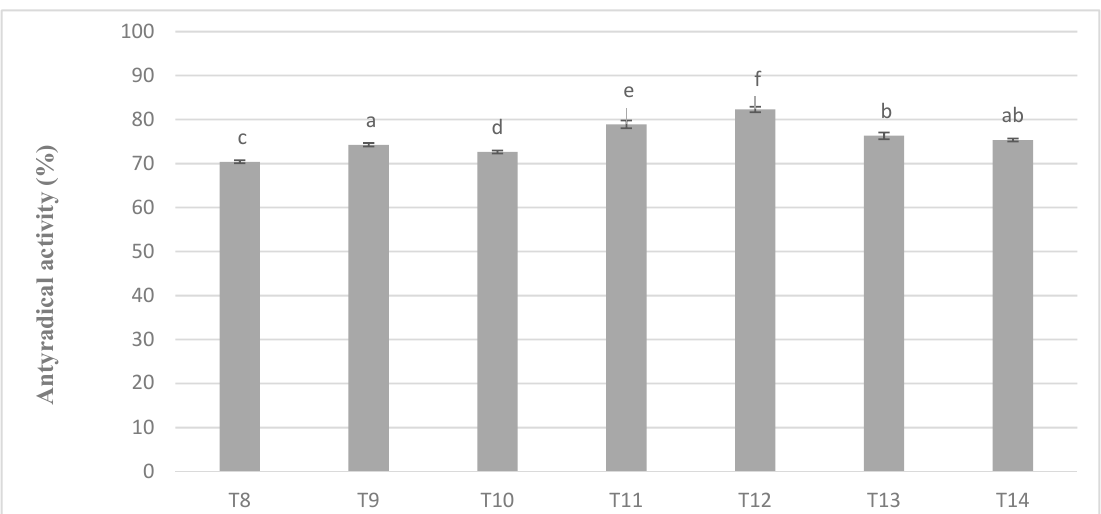
Figure 5. Antioxidant activity in chocolate milk masses prepared from Ivory Coast cocoa liquor (the same letter means that there are no statistically significant differences between the analyzed products at a confidence level of α = 0.05; the abbreviations used in the graph are described in Table 3).